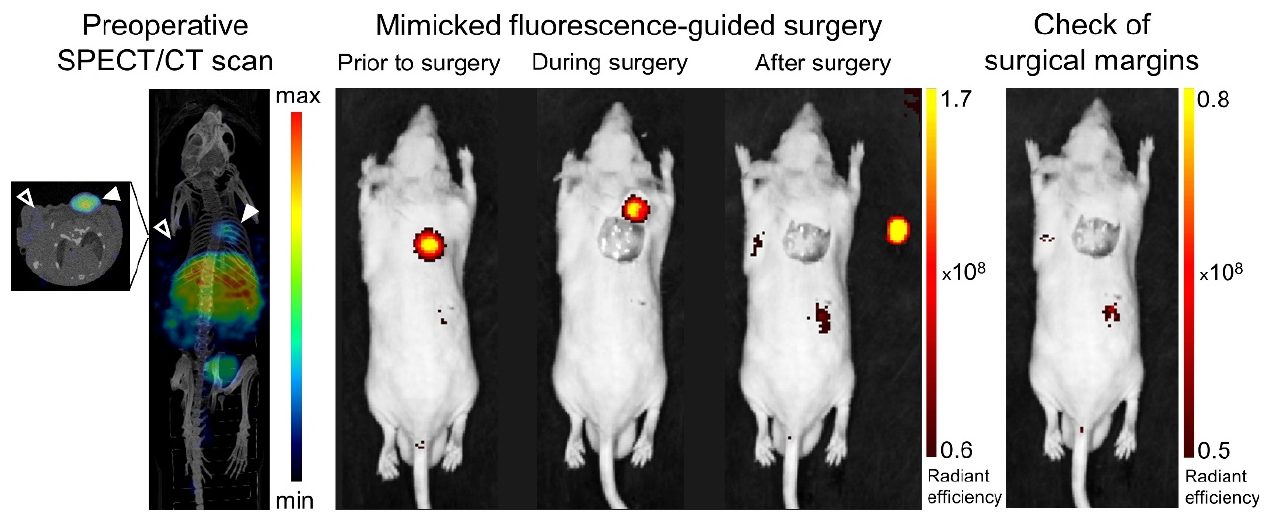
Figure 5. Proof-of-concept image-guided surgery on PC-3 ( ▲ ; right shoulder) and NCI-H69 ( Δ ; left shoulder) tumor-bearing mice at 24 h post injection 20 MBq/0.75 nmol [ 111 In]In- 14 . Shown are a pre-operative SPECT/CT scan ( left panel ), post-mortem merged photograph and fl uorescence images obtained prior to, during and after PC-3 tumor resection ( middle panel ), plus a fi nal image to check